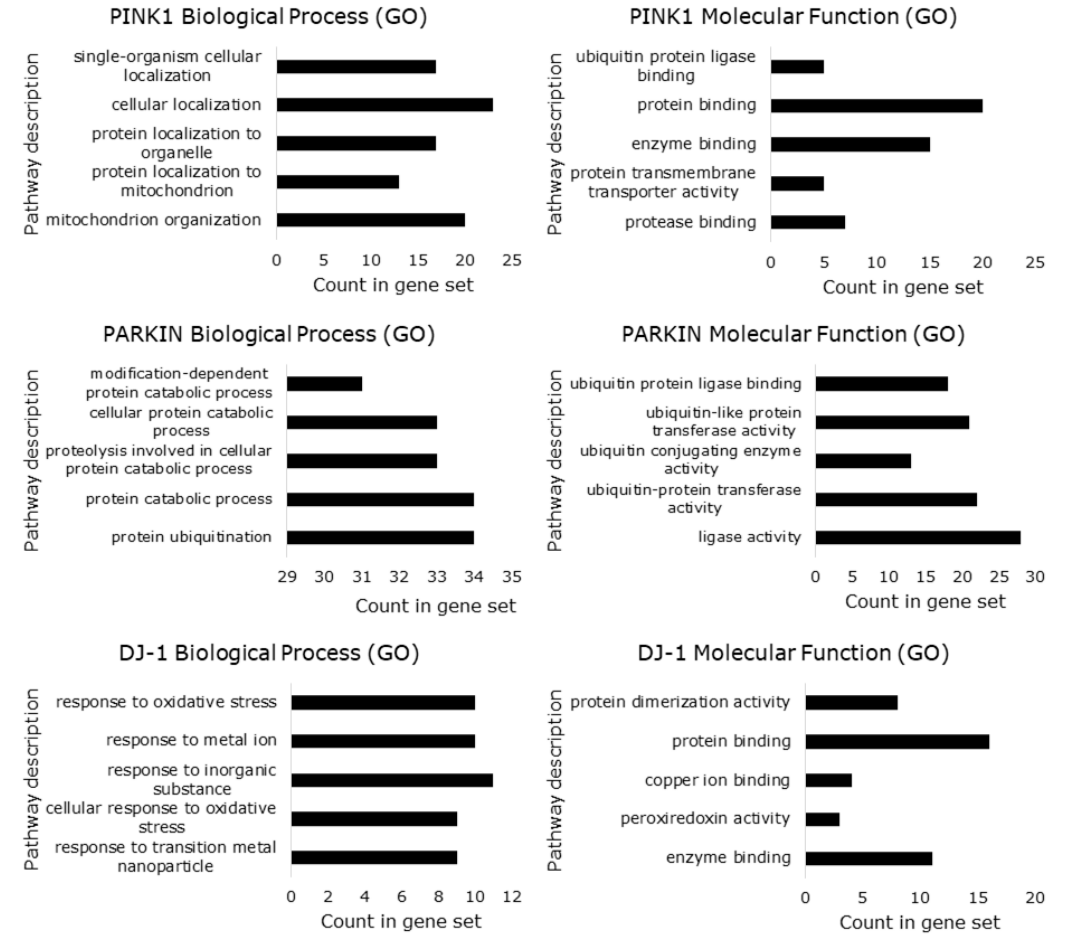
Figure 6. Gene ontology enrichment analysis for biological processes and molecular function in the interaction networks of PINK1, PARKIN, and DJ-1. The numbers on the horizontal axis represent the enrichment score. A high enrichment score related to the genes were found more frequently in the ontology.